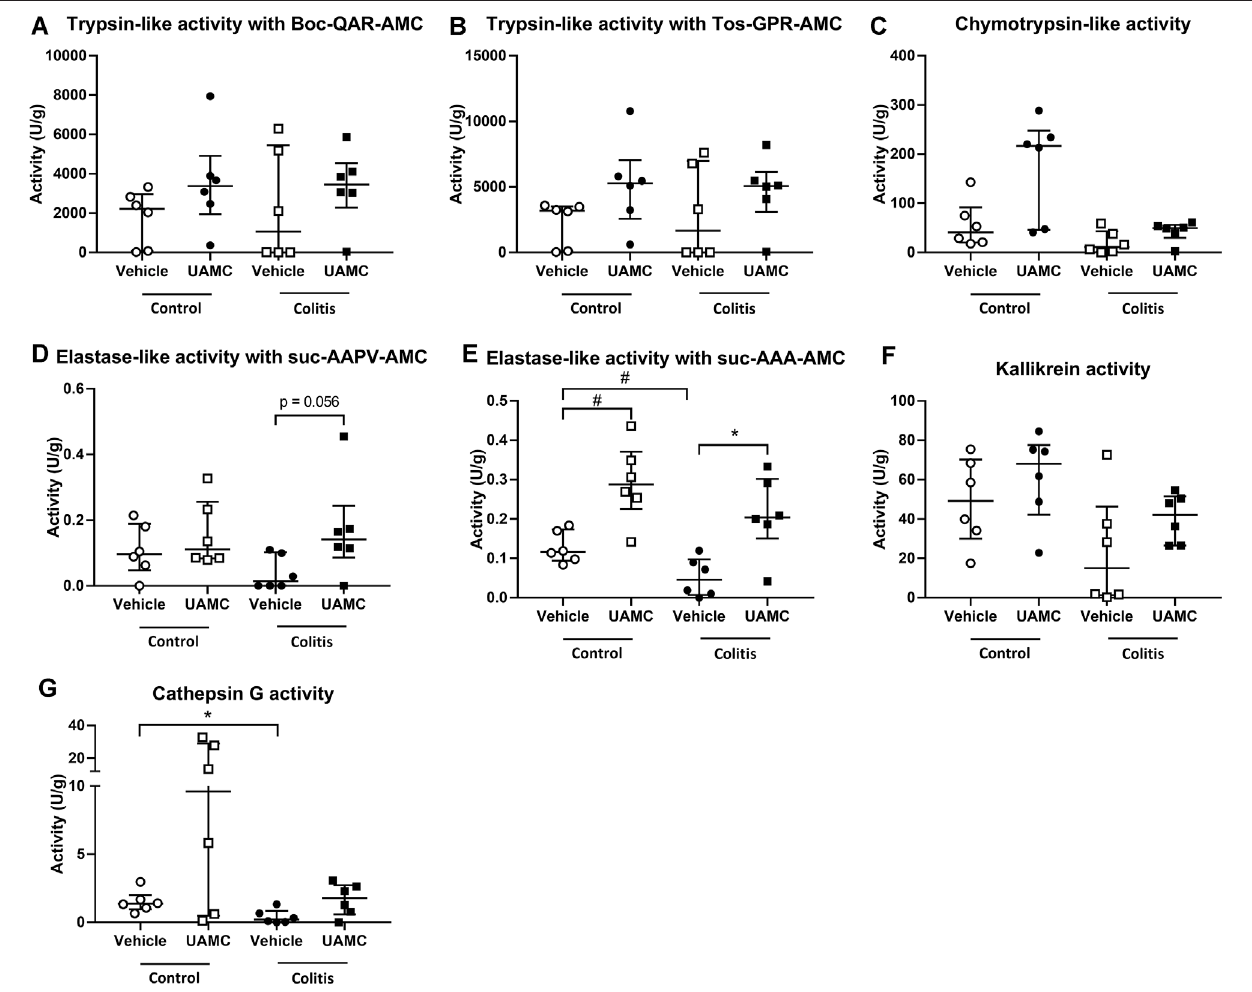
FIGURE 7 | Proteolytic activities measured with fl uorogenic substrates in fecal samples from control and acute colitis rats treated with UAMC-00050 (1 mg/kg) or vehicle (5% DMSO). (A) Trypsin-like activity measured with Boc-QAR-AMC (B) Trypsin-like activity measured with Tos-GPR-AMC (C) Chymotrypsin-like activity measured with suc-AAPF-AMC (D) Elastase-like activity measured with Suc-AAPV-AMC (E) Elastase-like activity measured with Suc-AAA-AMC (F) Kallikrein activity measured with H-PFR-AMC (G) Cathepsin-G activity measured with suc-AAPF-AMC and the cathepsin G inhibitor I. Data are presented as median with interquartile range (IQR). Data were analyzed using two-way ANOVA with “ treatment ” and “ group ” factors followed by unpaired T-tests with Bonferroni correction for multiplicity(for trypsin-likeactivity measured withBoc-QAR-AMCand Tos-GPR-AMC,elastase-like activity measured withSuc-AAA-AMC and kallikrein activity), and by Mann – Whitney U tests with Bonferroni correction for multiplicity (for chymotrypsin-like activity, elastase-like activity measured with suc-AAPV-AMC and cathepsin-G activity); n = 6 – 8 per group. * p < 0.05; signi fi cantly different from colitis + vehicle; # p < 0.05; signi fi cantly different from control + vehicle.